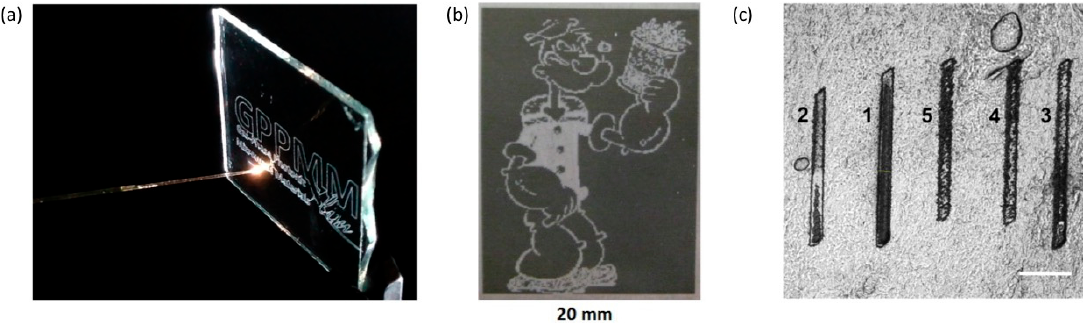
Figure 25. Illustrations of different applications of HCPCF fiber laser beam delivery, with ( a ) glass engraving ((reprinted with permission from Reference [17], OSA, 2013), ( b ) titanium micromachining (reprinted with permission from Reference [107], OSA, 2015), and ( c ) tissue surface ablation (reprinted with permission from Reference [111], OSA, 2016).